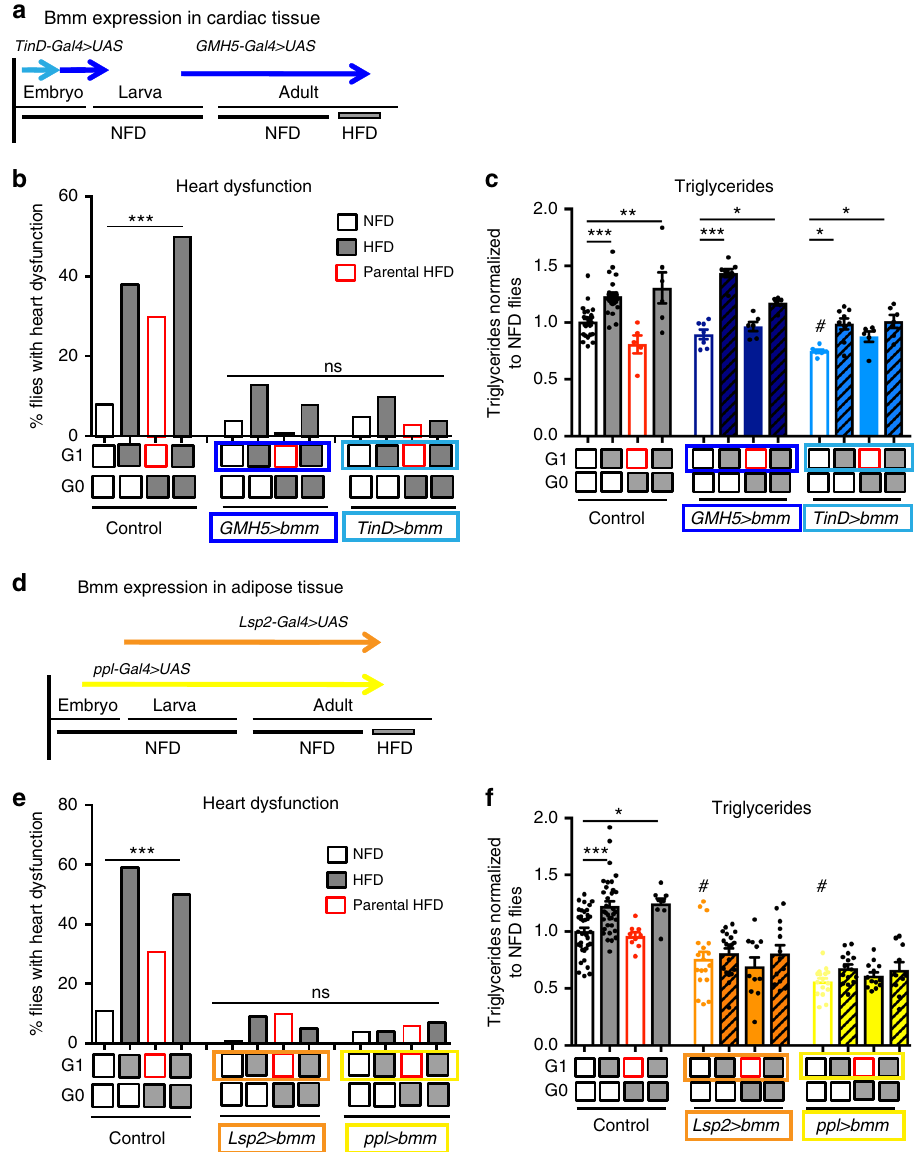
Fig. 4 Tissue-restricted expression of bmm lipase protects the heart from parental or acute HFD. a Schematic illustration of the temporal expression of myocardial Gal4 drivers in the embryonic, larval, and adult stages. TinD -Gal4-driven expression (light blue arrow) is restricted to the dorsal mesoderm/ cardiac progenitor cells at early to mid-embryogenesis 25 . The GMH5 -Gal4 driver (dark blue arrow) is active during mid to late embryogenesis, and again throughout adulthood 48 . Gray box indicates 5 days of HFD exposure. b Cumulative incidence of heart defects and c TAG content in G1 upon parental or acute HFD ( n = 24 – 30 fl ies and n = 6 – 23 samples respectively). d Schematic illustration of the temporal expression of adipose-speci fi c Gal4 drivers. ppl - Gal4 27 (yellow arrow) expression is restricted to the embryonic, larval, and adult stages, and Lsp2 -Gal4 (orange arrow) is active during the larval and young